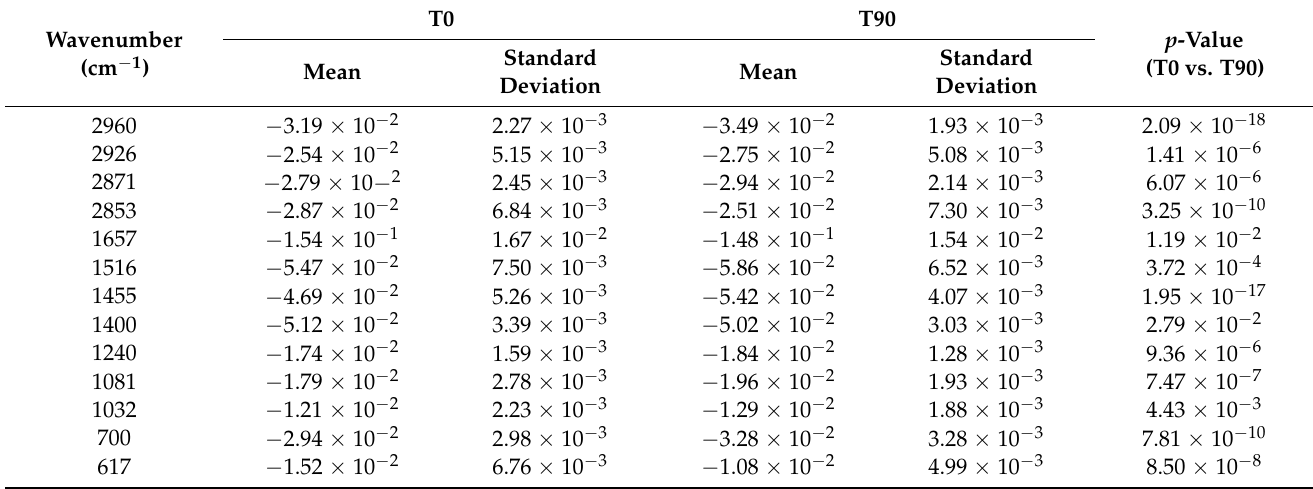
Table 3. Mean values and standard deviations of negative bands of the normalized second derivative spectra of sera at T0 and T90, respectively, and the p -value of Student’s t -test regarding the comparison between T0 and T90, at p <